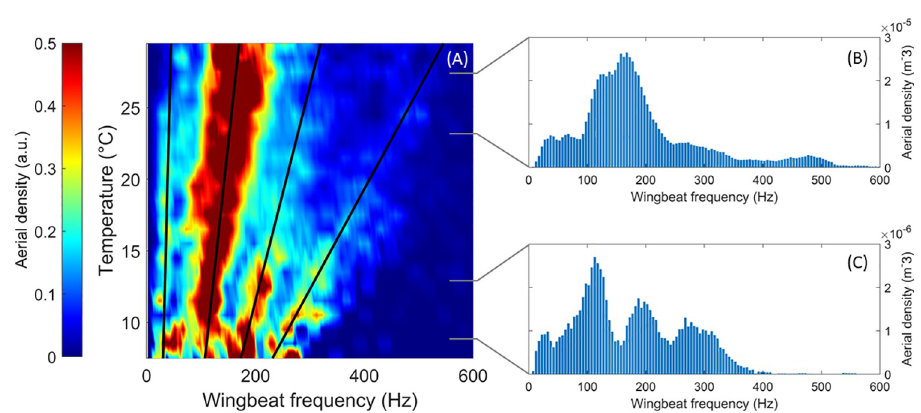
Fig 4. Relative aerial density per bin of temperature and wingbeat frequency (A) along with the wingbeat frequency distribution for two ranges of temperature, 22 to 26˚C and 8 to 12˚C (respectively B and C). On figure A the aerial density was rescaled from 0 to 1, for each temperature bin by normalizing with the maximal value in order to emphasize local maximums. Black lines represent the linear fit of local maximal for each of the four insects cluster, illustrating the drift of the wingbeat frequency with the